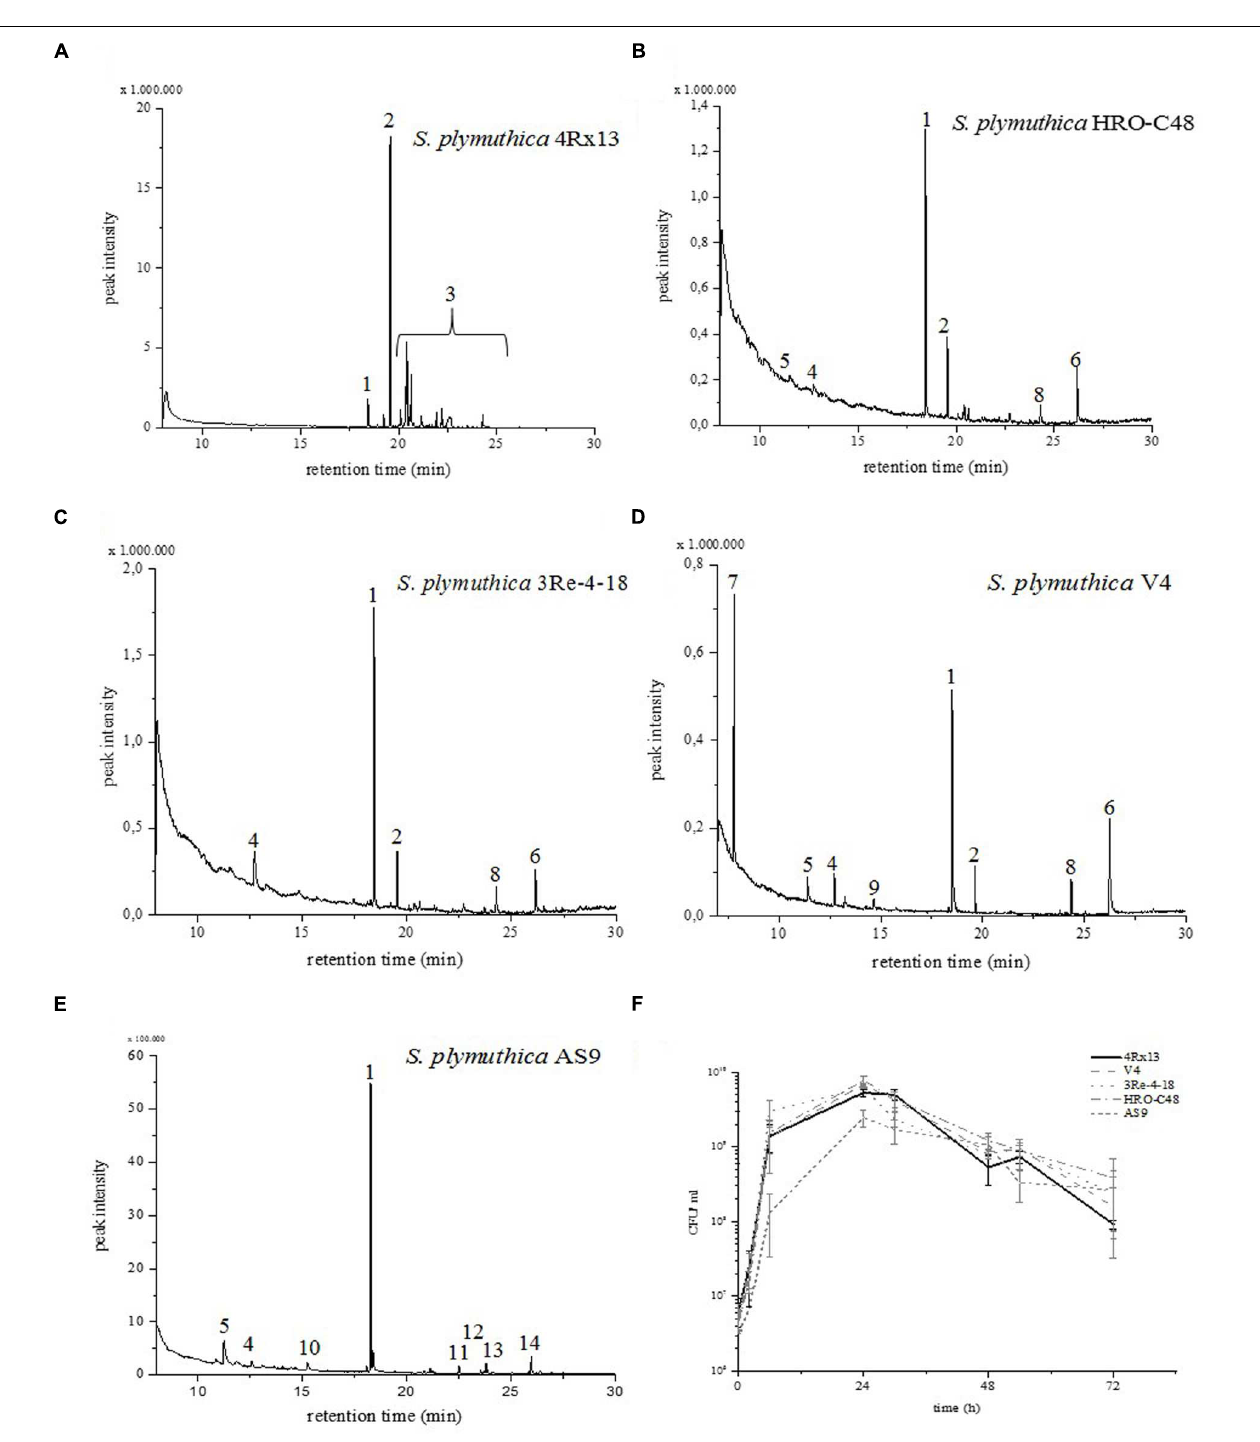
FIGURE 2 | VOC profiles and growth curves of Serratia plymuthica isolates. The emitted volatiles of the headspaces of (A) S. plymuthica 4Rx13, (B) S. plymuthica HRO-C48, (C) S. plymuthica 3Re-4–18, (D) S. plymuthica V4, and (E) S. plymuthica AS9 were harvested in a VOC collection system when strains grew in a complex medium (NB II). Volatiles were analyzed by GCMS (VOC trapping time interval 24–48 h). Compounds were identified by comparing the mass spectra with those filed in the Nist107 library. (#1) nonyl acetate was internal standard (peak corresponds to 5 ng), (#2) sodorifen, (#3) sodorifen isomers, (#4) dimethyl trisulfide, (#5) pyrazine, (#6) hexadecen-1-ol, (#7) dimethyl disulfide, (#8) 2-nonanone, (#9) diethyl ester, (#10) 2-hexanone, (#11) 2-phenylethanol, (#12) undecanone, (#13) 2-butanone, and (#14) n-heptadecyl ester. (F) The growth curves of all five S. plymuthica isolates were obtained by determining CFU/ml over the time interval 0–72 h. Standard deviations were calculated ( n =